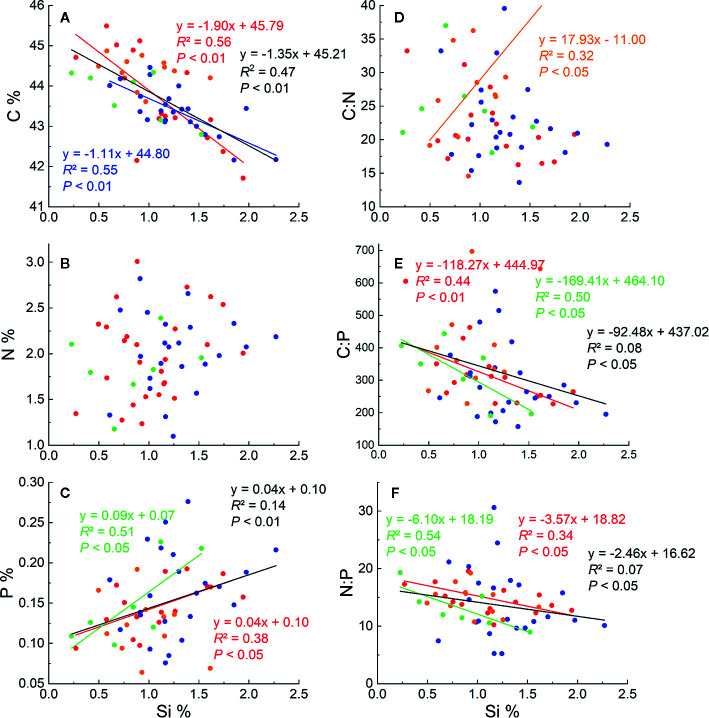
Relationships between Si concentrations and C, N, and P concentrations (A–C), Si concentrations and stoichiometric ratios of N:P, C:P, and C:N (D–F) for these four species. The red dots, lines and text represent Leymus chinensis, blue represent Cleistogenes squarrosa, the green represent Agropyron mongolicum and yellow represent Stipa krylovii. The black dots, lines, and text represent all grass samples.